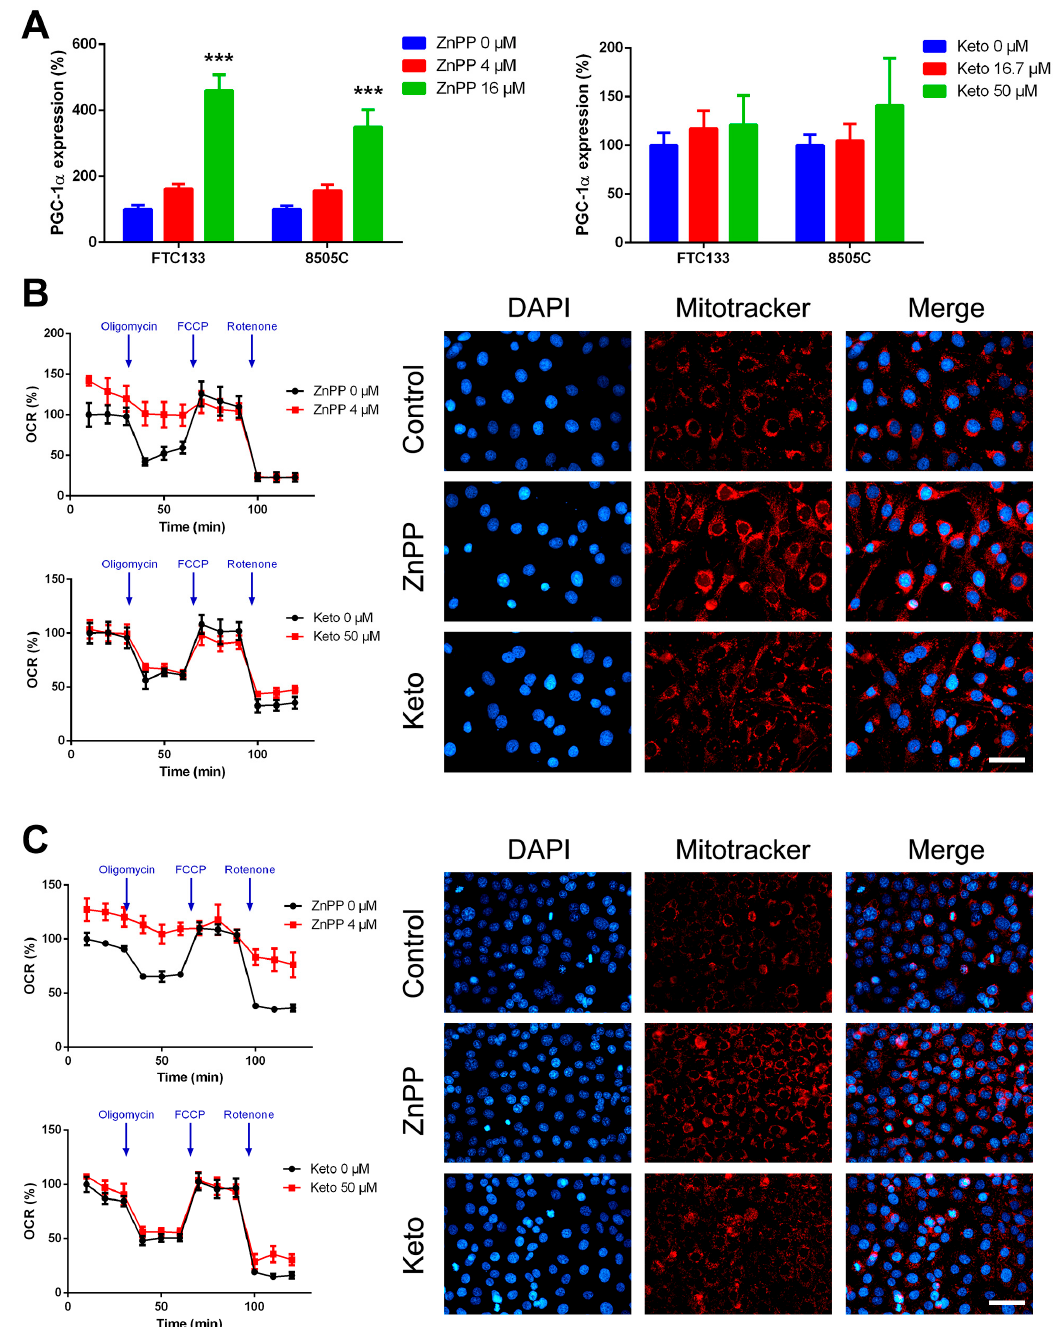
Figure 5. Metabolic alterations induced by heme oxygenase-1 inhibitors in thyroid cancer cells. The expression of peroxisome proliferator-activated receptor gamma coactivator 1-alpha (PGC-1 α ) was determined following treatment with zinc protoporphyrin-IX (ZnPP), ketoconazole (Keto), or vehicle control ( A ). Corresponding changes in oxygen consumption rates (OCR) and MitoTracker staining were evaluated in FTC-133 ( B ) and 8505C ( C ) cells. *** p < 0.001 versus control. Scale bar, 50 μ m.